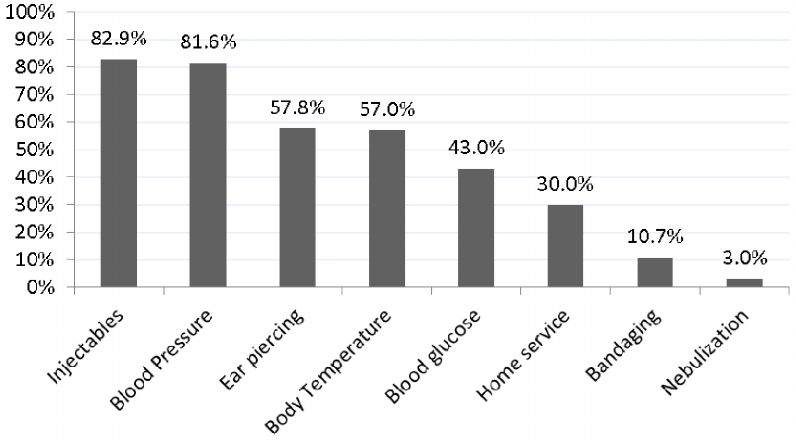
FIGURE 3 - Pharmaceutical services performed by pharmacists in the State of